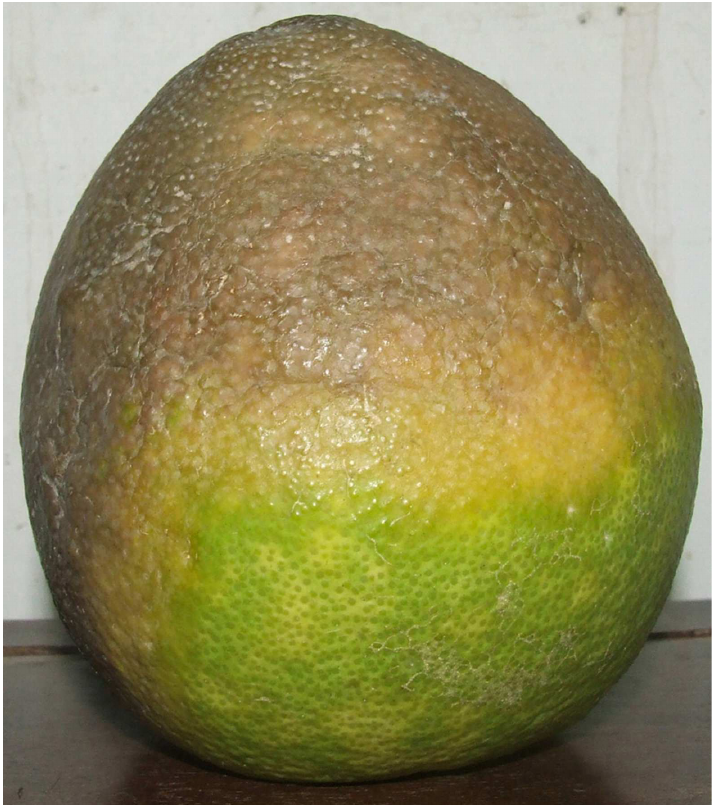
Fig 1. Fruit of pomelo ( Citrus grandis ) with symptoms of brown rot caused by mixed infections of P . sp. prodigiosa and P . sp. mekongensis from